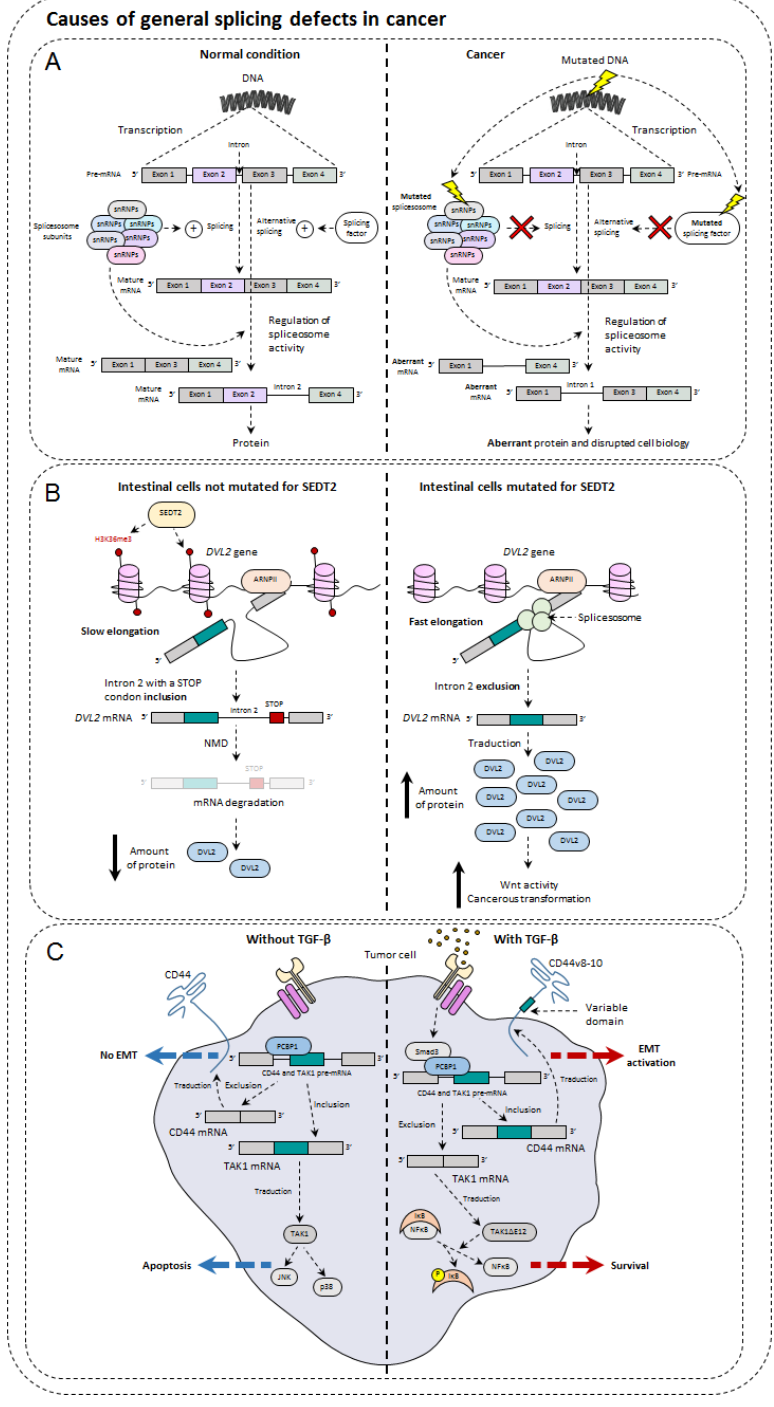
Figure 4. Causes of general splicing defects in cancer. ( A ) Impact of somatic DNA mutation on splicing in cancer cells. ( B ) Impact of SEDT2 mutation on DVL2 mRNA in intestinal cells. ( C ) Role of TGF- β on AS in cancer